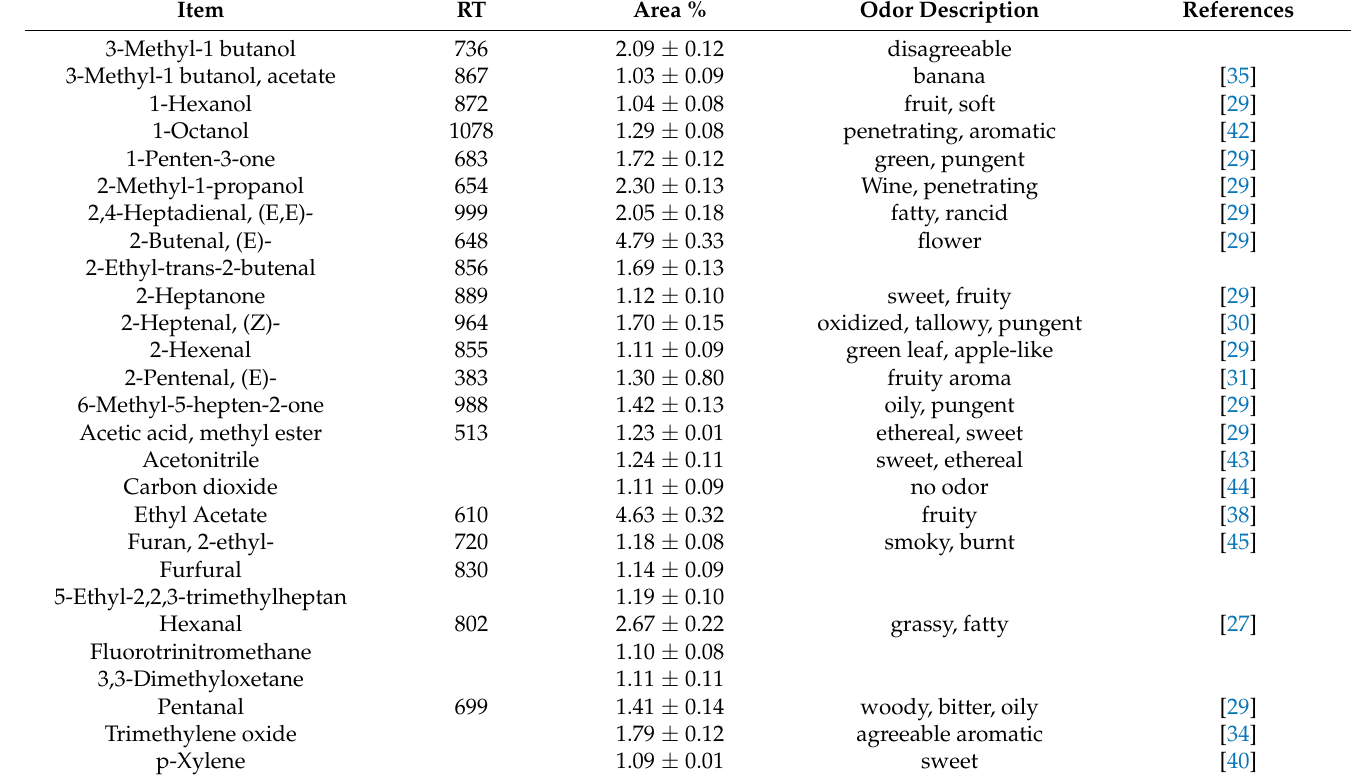
Table 8. Percentage composition of volatile compounds from cuckooflower seed oil obtained by